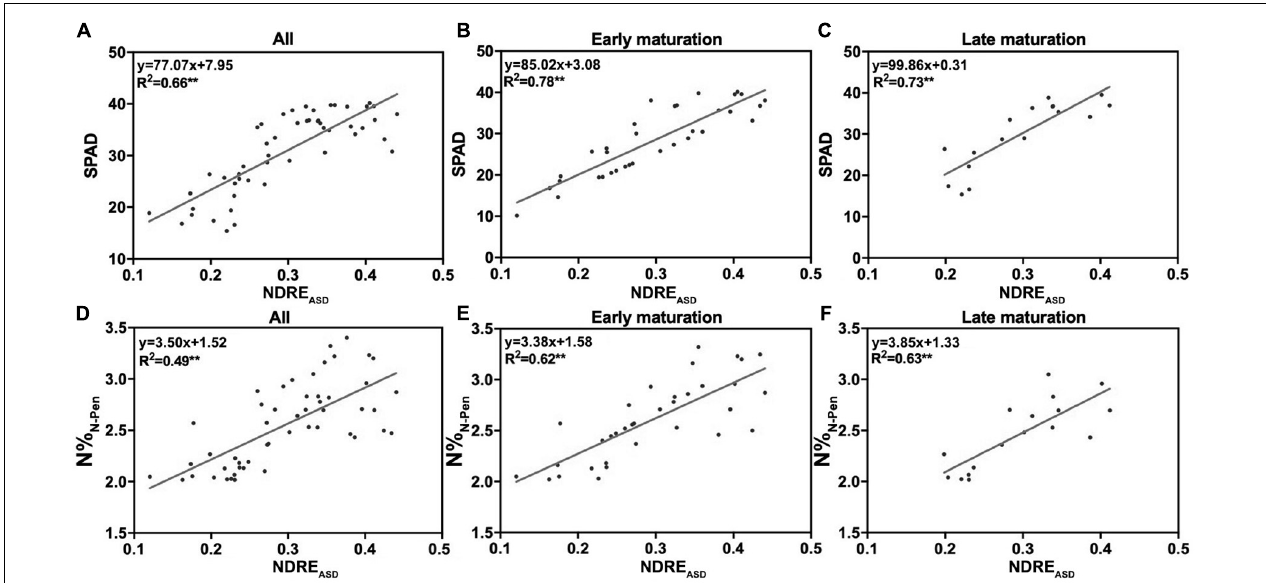
FIGURE 4 | The relationship of NDRE ASD with SPAD and N% N - Pen . The relationship of NDRE ASD with SPAD for (A) all varieties, (B) early maturation varieties, and (C) late maturation varieties. The relationship of NDRE ASD with N% N - Pen for (D) all varieties, (E) early maturation varieties, and (F) late maturation varieties; ** P < 0.01.